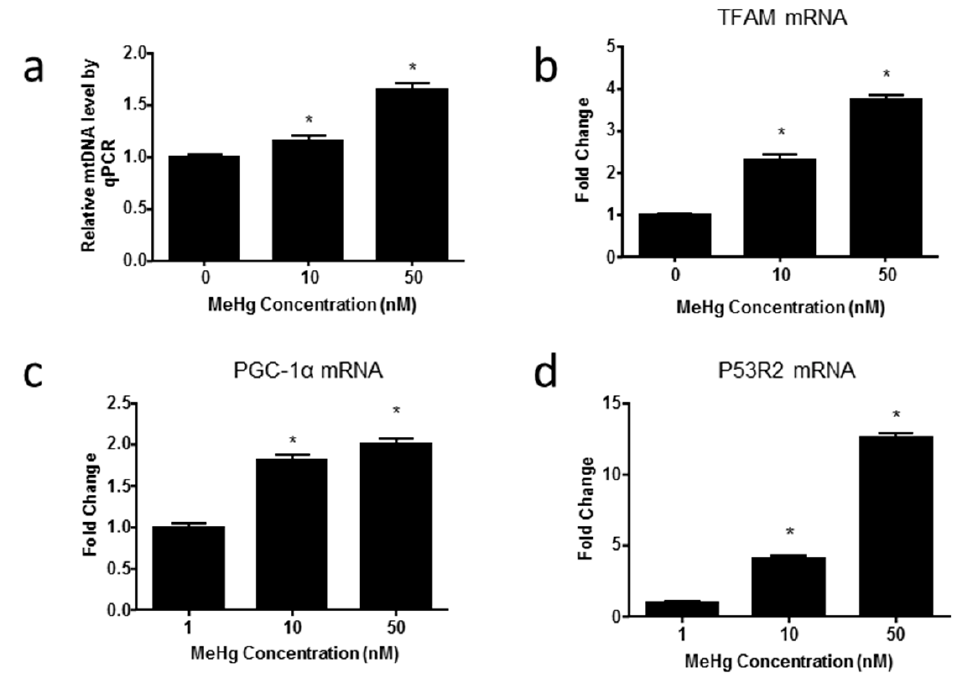
Figure 4. MeHg alters the expression of genes regulating mitochondrial biogenesis ( a ) The relative mitochondrial DNA (mtDNA) were presented as fold differences based on control. Results are expressed as mean ± SEM ( n = 3). * p < 0.05 when compared with the corresponding control group (0 nM MeHg); ( b – d ) qPCR analysis of peroxisome-proliferator-activated receptor gammacoactivator-1 α (PGC-1 α ), mitochondrial transcription factor A (TFAM) and p53-controlled ribonucleotide reductase (p53R2) mRNA expression levels performed on RNA extracted from ihNPCs treated with 0 nM, 10 nM and 50 nM of MeHg. Relative mRNA levels were presented as fold differences based on control. Results are expressed as mean ± SEM ( n = 3). * p < 0.05 when compared with the corresponding control group (0 nM MeHg).